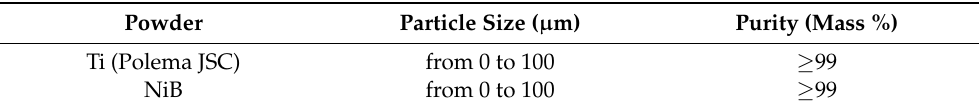
Table 1. Initial